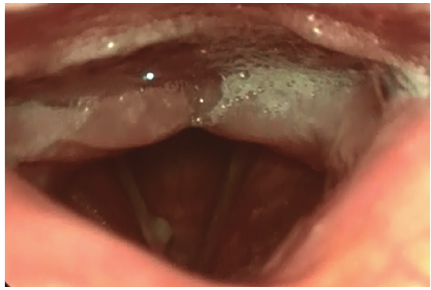
Figure 1: Endoscopic view of the submucosal nodular lesion with a smooth surface that is located in the middle of the right vocal cord.